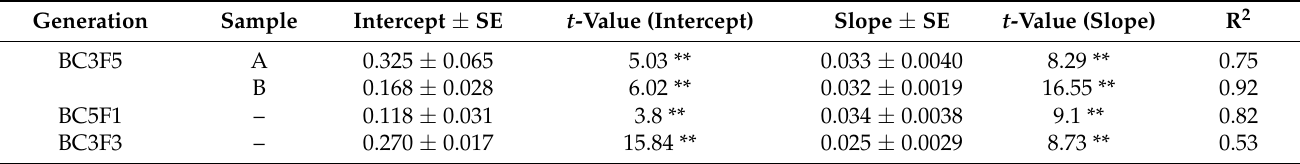
Figure 9. Relationship between absorbance at 264 nm and 7-epi zingiberene contents of BC3F5 plants sampled by two methods, A and B (see text). Table 4. Estimates of intercepts, slopes, and their t - and R 2 -values from regression of absorbance at 264 nm on 7- epizingberene content leaflet washes, measured by GC-FID (ng/ µ L) for two sampling procedures of the BC3F5 generation and for the BC5F1 and BC3F3 generations of interspecific hybrid tomatoes. For the BC3F3 generation, estimates are for the regression of absorbance on total zingiberenoid content (ng/ µ L of 7-epi zingiberene + 9-hydroxy zingiberene + 9-hydroxy, 10,11-epoxy zingiberene) measured by